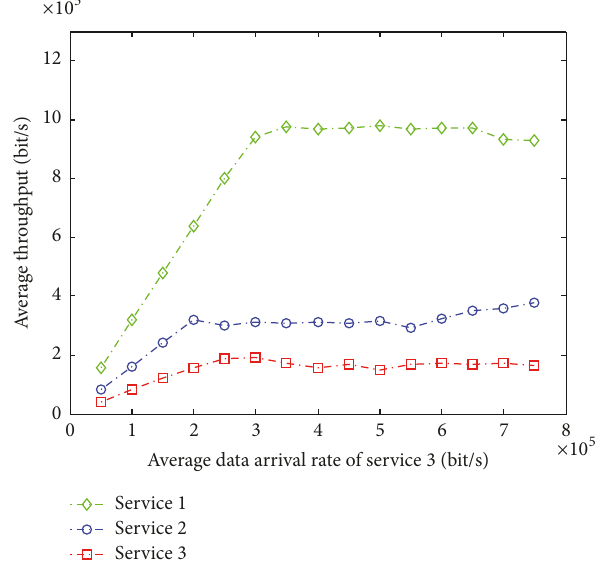
Figure 9: Comparison of average throughput in multihop network.